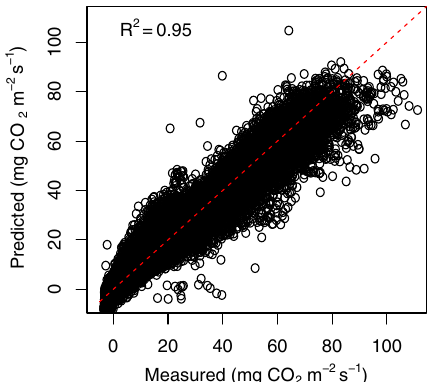
Figure 4. Relationship between the measured and predicted leaf CO 2 exchange in Finnish Lapland, 68 ◦ N in the year 2013. The dashed line represents the 1 : 1